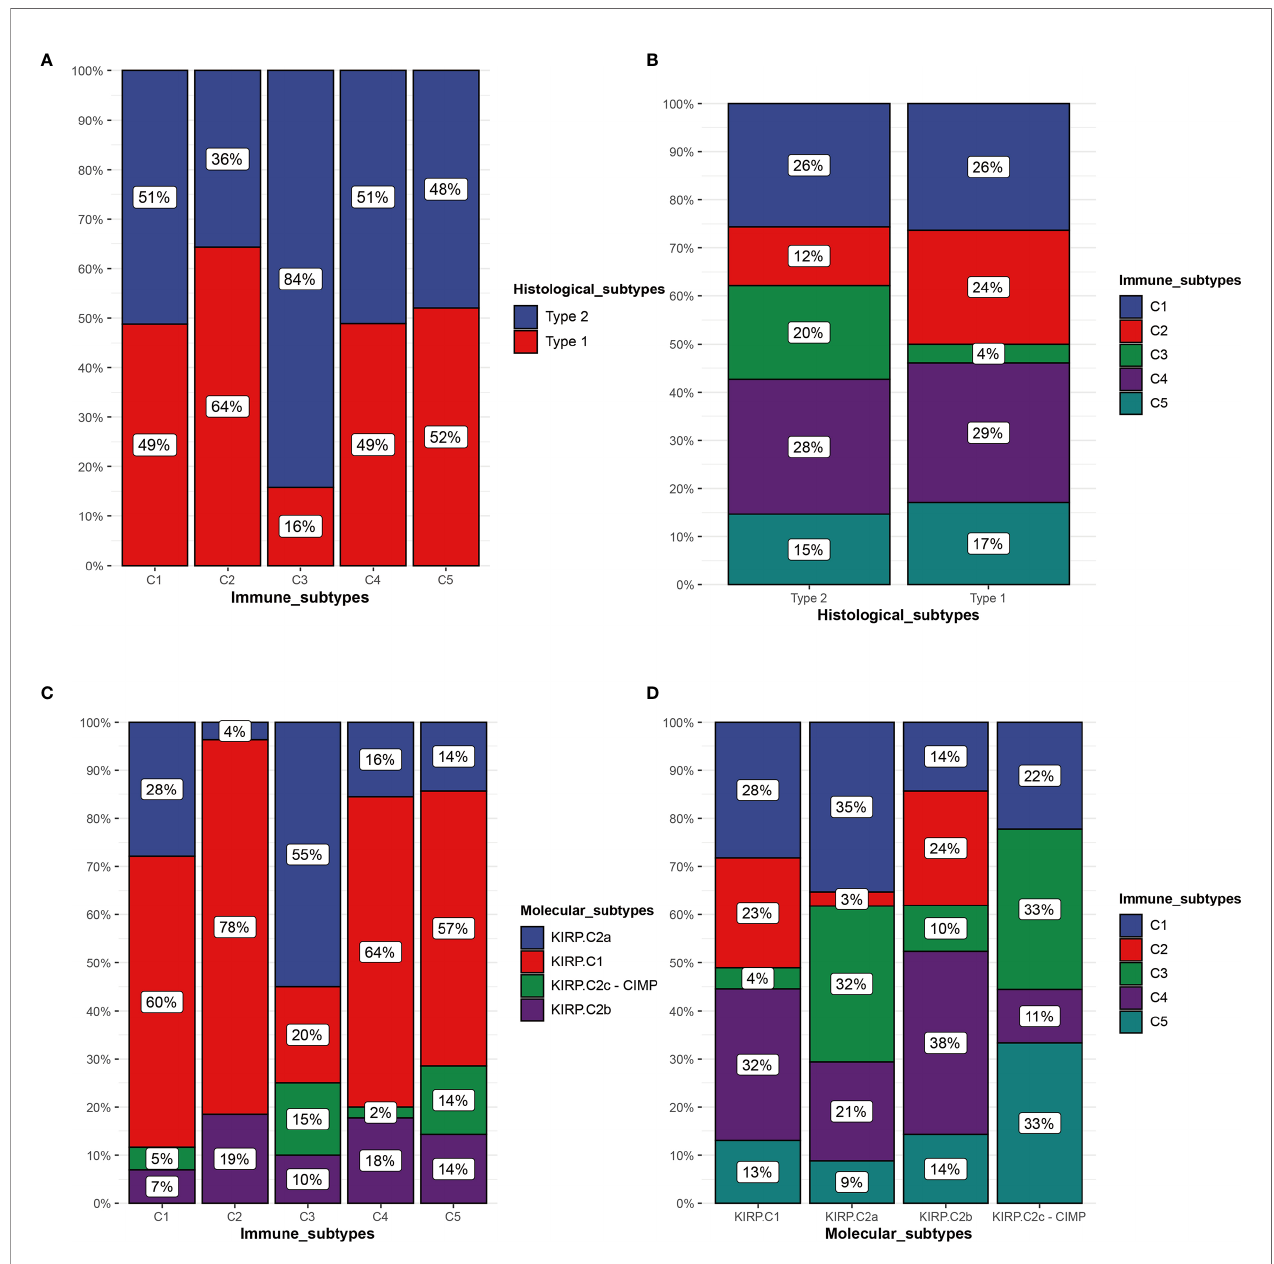
FIGURE 10 | Comparison of multiple KIRP subtypes. (A) Percentage of histological subtypes in immune subtypes. (B) Percentage of immune subtypes in histological subtypes. (C) Percentage of molecular subtypes in immune subtypes. (D) Percentage of immune subtypes in molecular